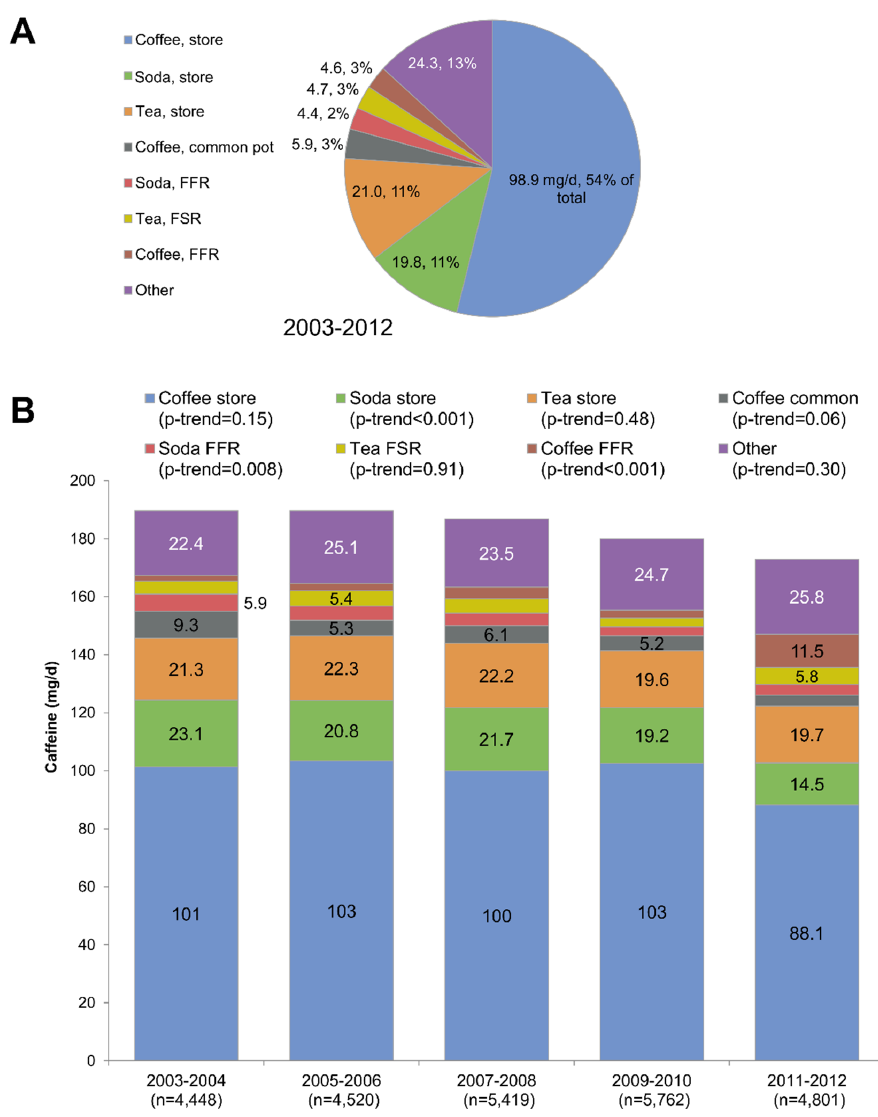
Figure 5. Trends in caffeine consumption by purchase location of origin and beverage type for population aged > 4 years. Data are for the period 2003–2012 ( A ) and shown separately for each NHANES cycle ( B ). FFR stands for fast food restaurant; FSR stands for full ‐ service restaurant.